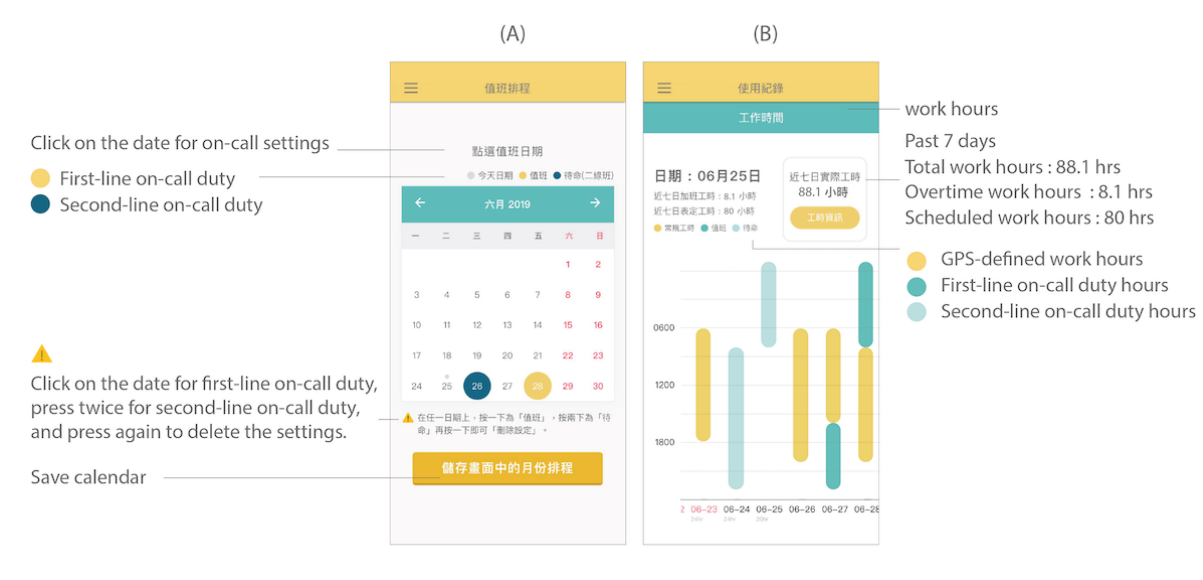
(Figure 2). For regular work hours, users should set a fixed starting and finishing time of work for weekdays upon installation; for on-call hours, users should input the dates in a month on which they have on-call duties (Figure 3). The app offers 2 selections for on-call duty hours, in line with the standard policies of the hospitals in Taiwan. Medical staff with first-line on-call duty are obligated to stay in the hospital overnight to care for patients and respond to any situations. Figure 3. Screenshots of app user interface. (A) The on-call dates settings. (B) The work-hour statistics and